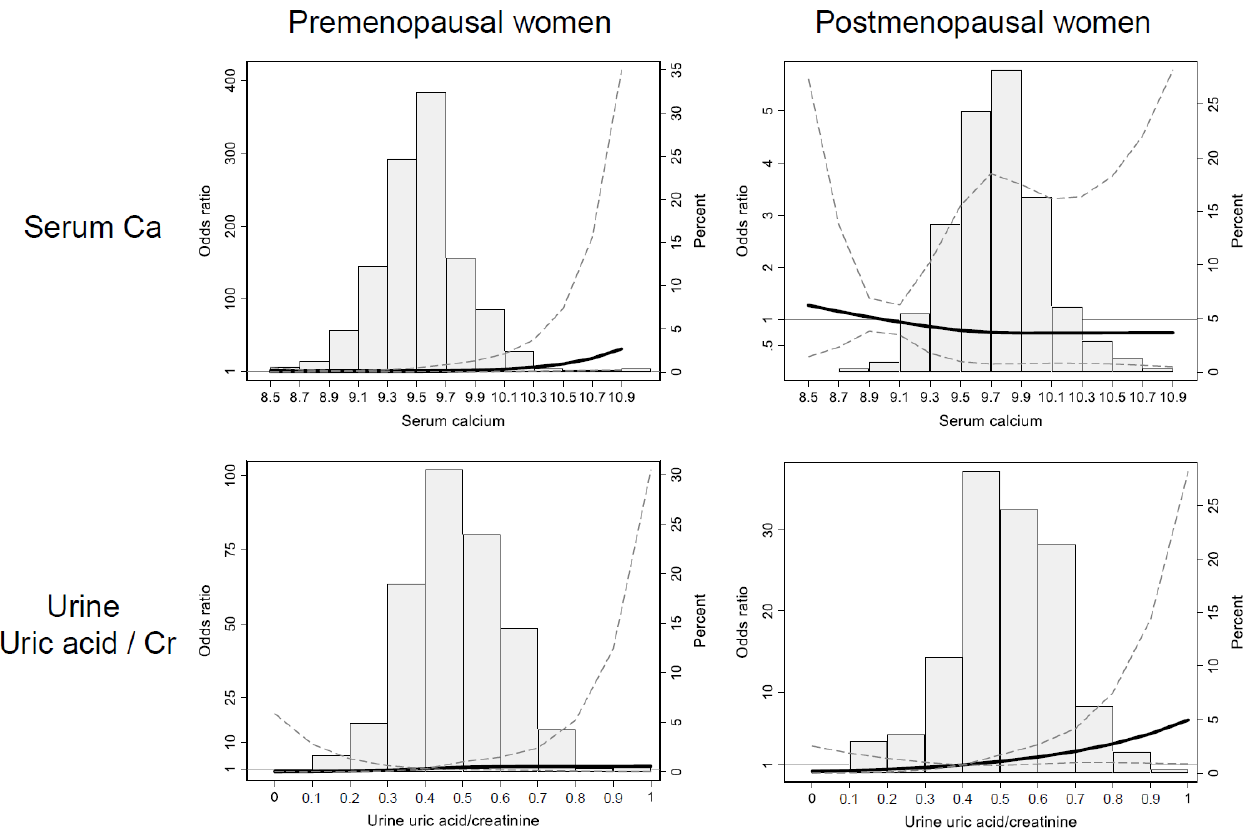
Figure 2. Multivariate-adjusted restricted cubic spline analysis of the effects of serum calcium ( upper row ) or urine uric acid levels ( lower row ) on osteoporosis risk in premenopausal ( left ) and postmenopausal ( right ) women. The bar plots show the frequency of patients on each value. The thick solid line shows the odds ratio, and the dashed line represents a 95% confidence interval. Abbreviations: Ca, calcium; Cr, creatinine).